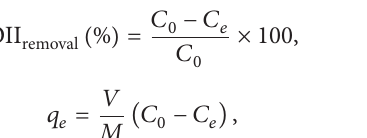
Table 2: Main characteristics of BCP adsorbent used in this study. Parameter Unit Value BET m 2 /g 12.69 Total pore volume cm 3 /g 0.198 ( 𝑃/𝑃 0 = 0.990 ) Mean pore diameter nm 49 Pores structure — Meso- and macroporous — 6.6 pH zpc Particle size nm